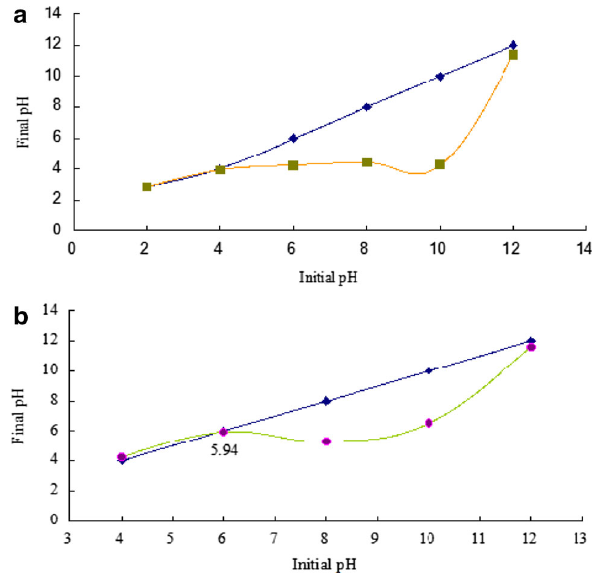
Fig. 1 a Graph of pH final versus pH initial for the adsorbent PKSAC suspension. b Graph of pH final versus pH initial graph for the adsorbent MPKSF suspension